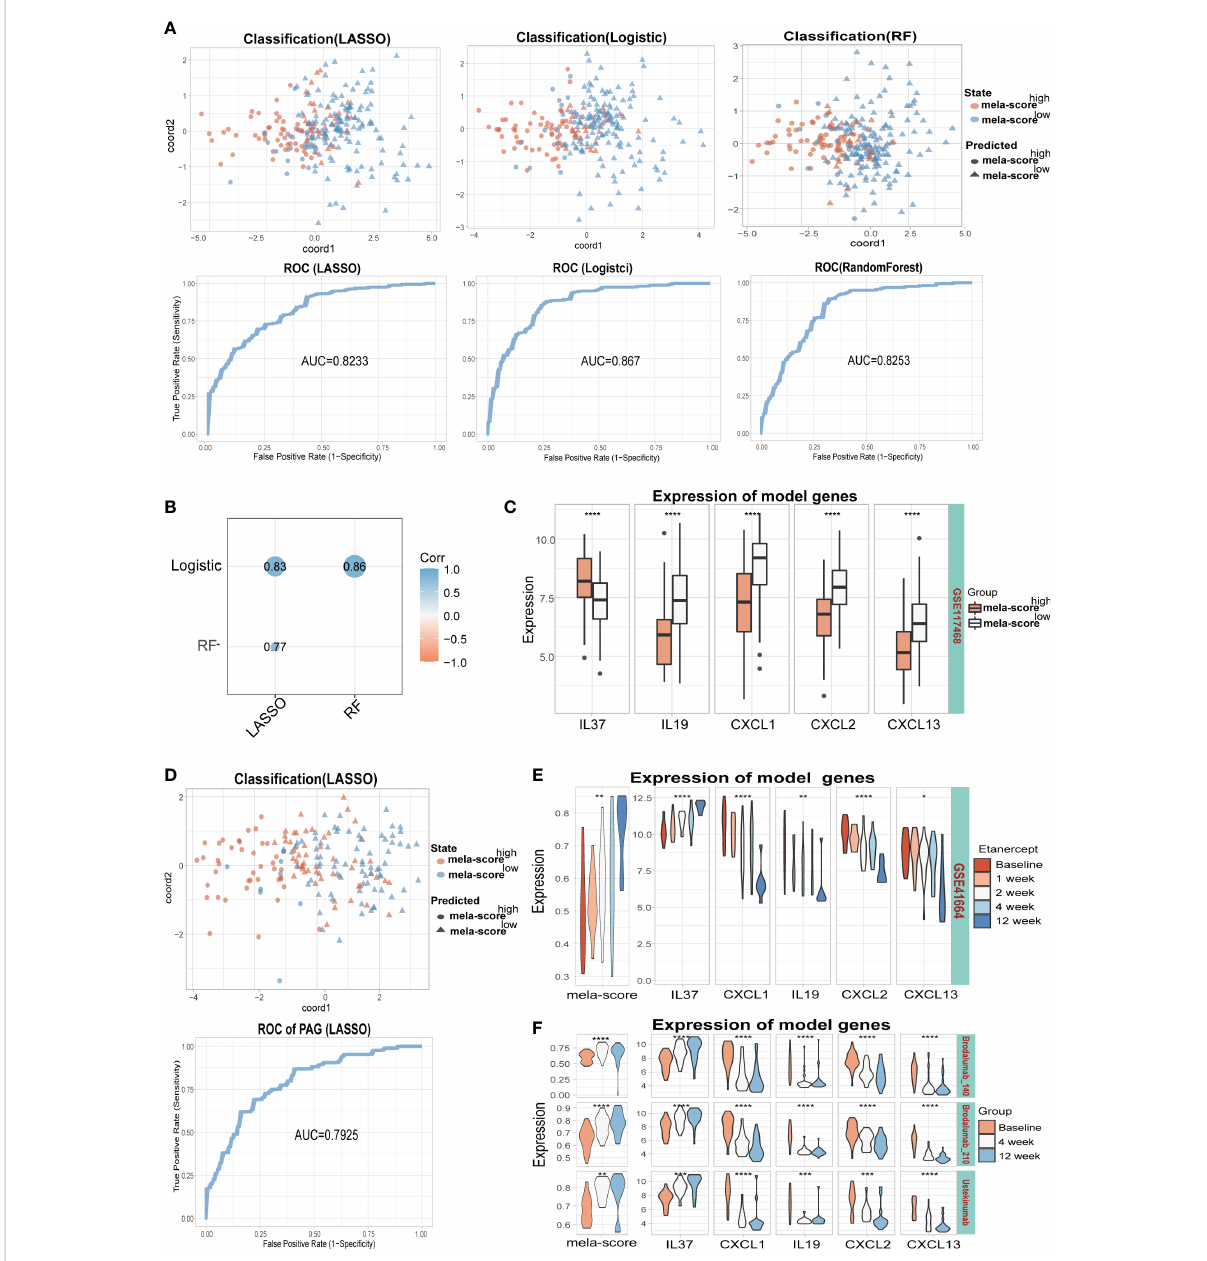
FIGURE 4 Training and testing models were built by different algorithms (LASSO, Logistic and RF). (A) The classi fi cation ability of the 3 models on training datasets (GSE41664, GSE30999, GSE13355). (B) Correlation between model scores in training data. (C) The expression levels of 5 model genes. (D) The classi fi cation ability and ROC of the LASSO model in testing dataset (GSE117468). The mela-score and expression levels of 5 in fl ammatory genes in GSE41664 (E) and GSE117468 (F) . *P < 0.05, **P < 0.01, ***P < 0.001,****P <